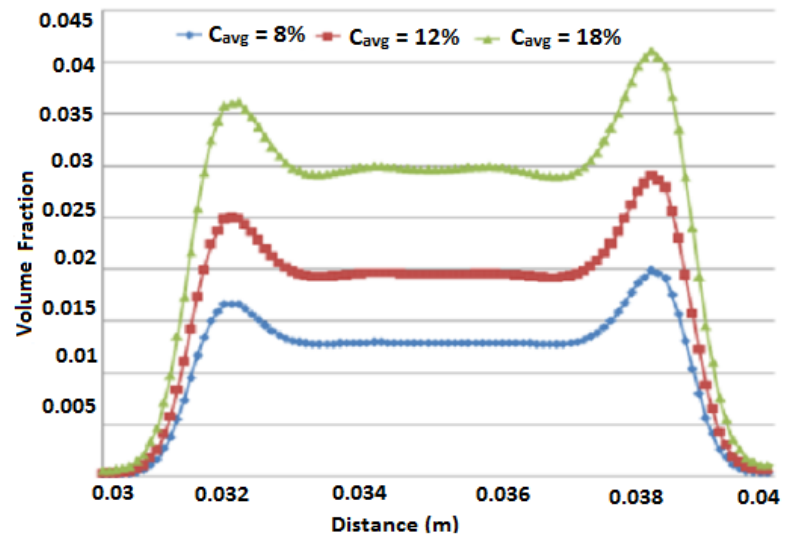
The only thing varying is the solid-phase content in the slurry. The nature of the concentration distribution of the solid phase across the cross section is the same for all the three percentages of solid concentration. As the percentage concentration increases in the slurry, the volume fractions of solid particles also increase in the proportional amount.